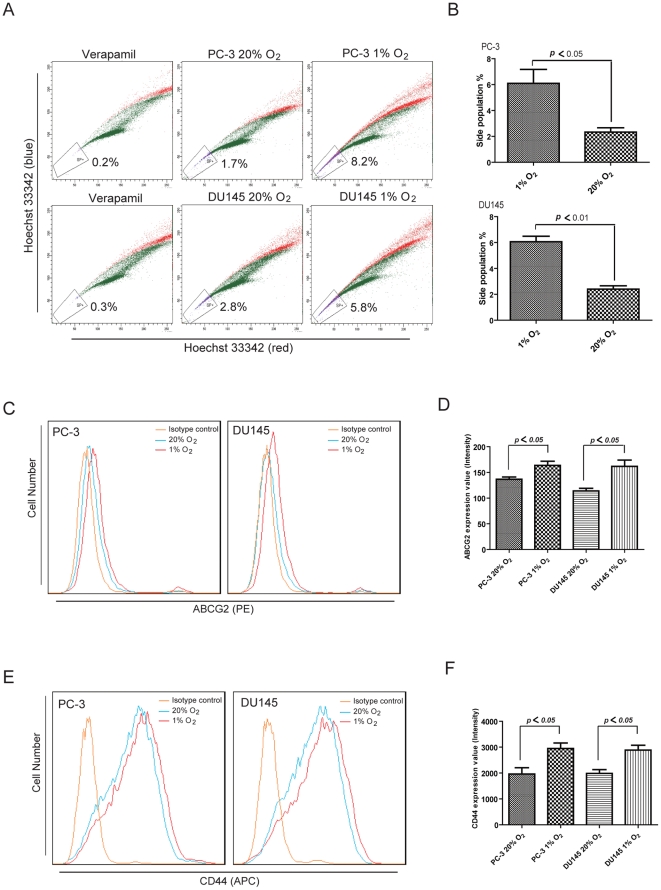
Stem-like phenotype analyses by flow cytometry.PC-3 and DU145 cells were cultivated in 1% O2 and 20% O2 coditions for 48 hours to analyze stem-like phenotype through flow cytometry assay. (A) The representative images show that side population cells were induced in both cell lines after hypoxic treatment. (B) Statistic analyses show significant difference in side population. (C) Flow cytometry analyses show higher levels of ABCG2 expression intensity in both cell lines under hypoxia. (D) Histogram shows statistically significant difference in ABCG2 expression. (E) Flow cytometry analyses show higher CD44 expression intensity in both cell lines under hypoxia. (F) Histogram shows statistically significant difference in CD44 expression.